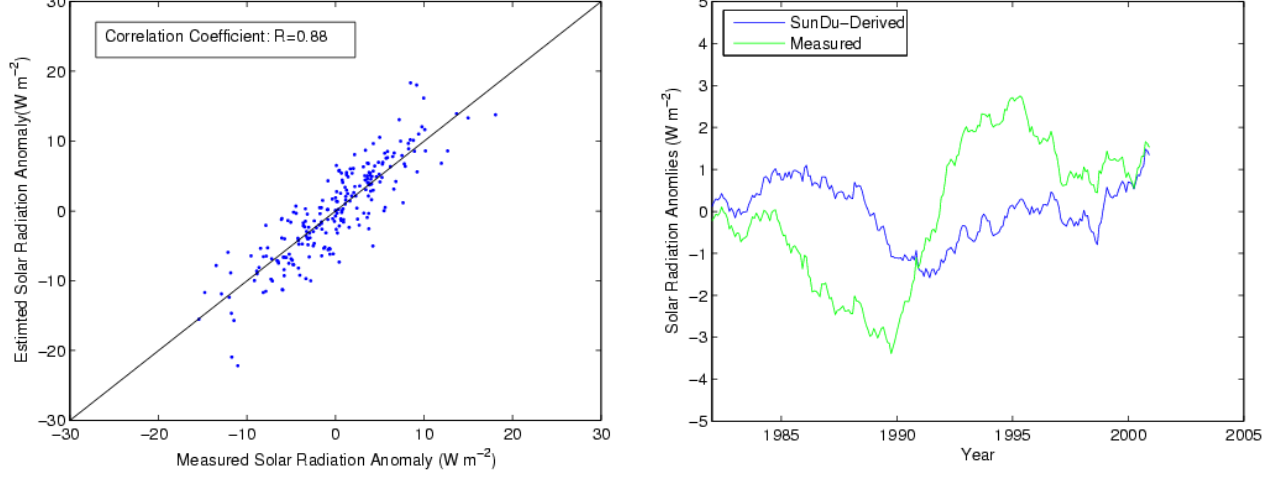
Fig. 5. Comparison between monthly regional R s anomalies of measurements and our prediction from SunDu. The regional average is over 51 stations in China (Table 1). Each point represents one month.